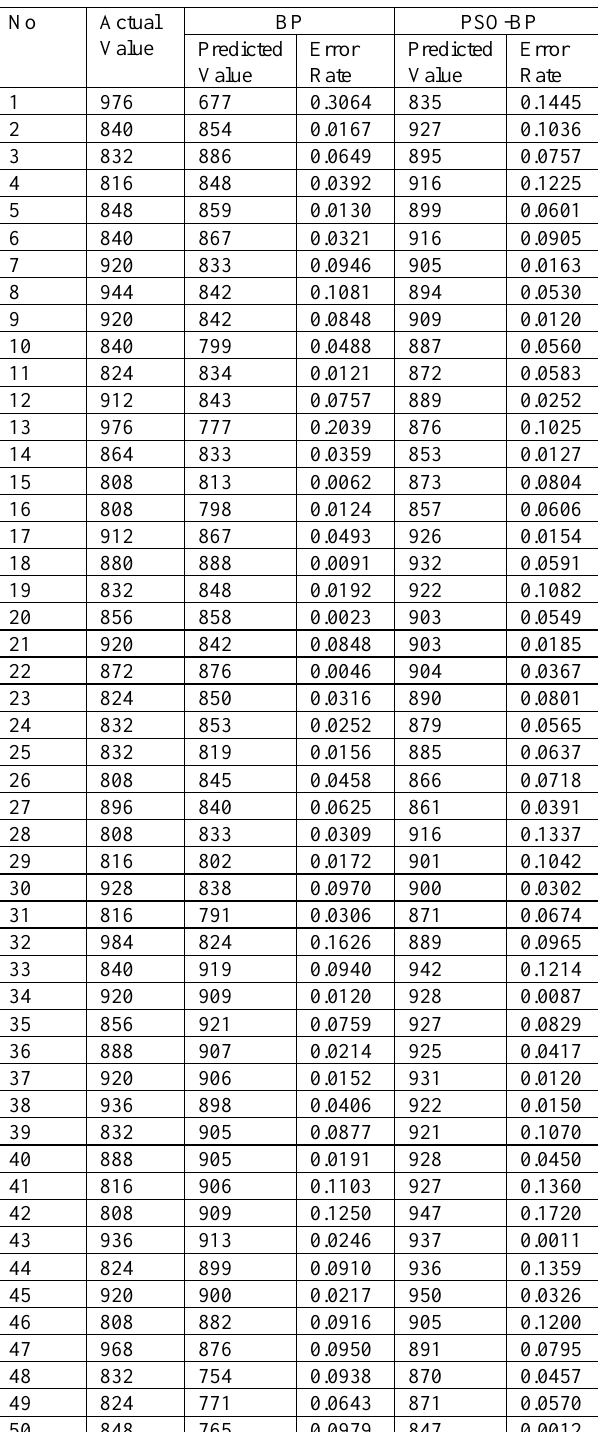
Figure 3 below shows the comparison of the error rates of the two algorithms for the data in Table 3. The prediction errors of the BP algorithm and the PSO-BP algorithm are very different, with the former having a large variance in the prediction results and the latter having a relatively flat prediction error. The errors of the two algorithms are mostly concentrated around